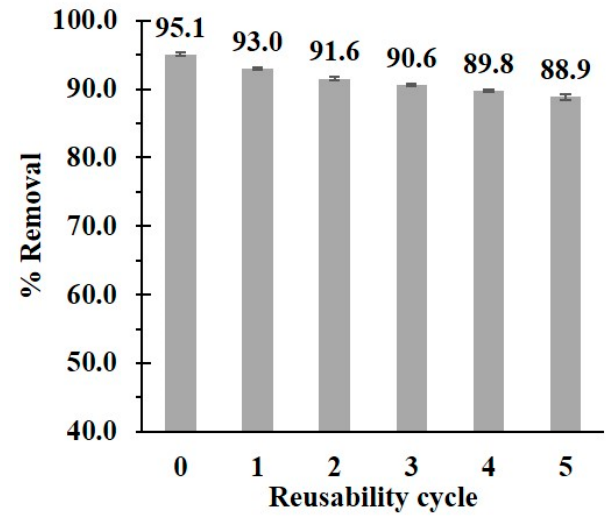
Figure 10. Reusability of BDP5 system for paraquat removal.